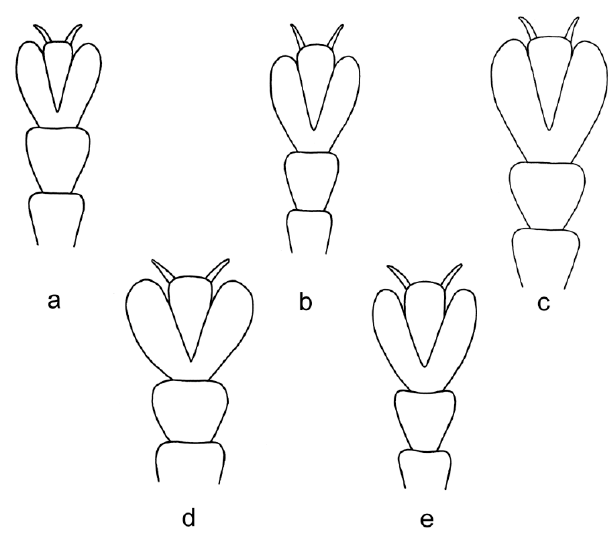
Figure 4. Protarsi of ( a ) Afroryzophilus djibai ; ( b ) A. centrafricanus ; ( c ) A. kuscheli ; ( d ) A. congoanus ; ( e ) A. somalicus. (Not at the same scale).